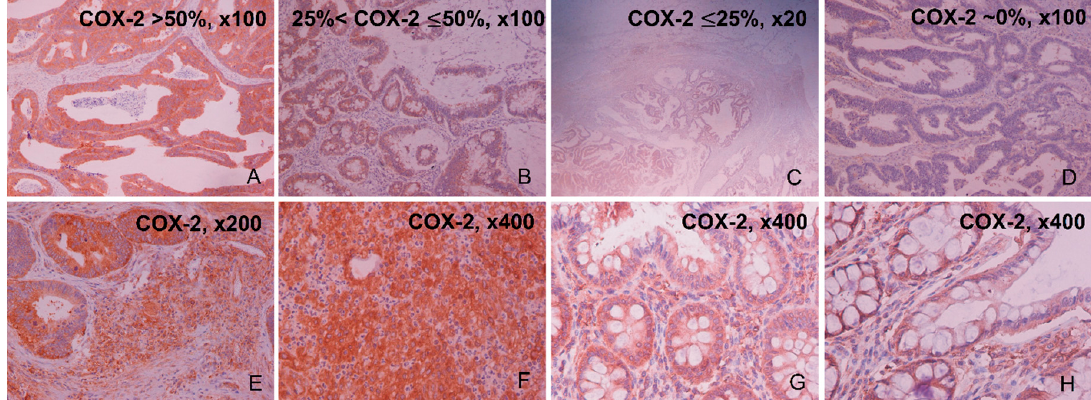
Figure 1. Representative slides of COX-2 staining in colorectal cancer (CRC) by immunohistochemistry (IHC). Colorectal adenocarcinomas with highly positive COX-2 immunoreaction (>50% of epithelial cancer cells; 22/49 (44.8%) CRC samples) ( A ), moderately positive (>25% and <50% of epithelial cancer cells; 14/49 (28.6%) CRC samples) ( B ), mildly positive (<25% of epithelial cancer cells; 5/49 (10.2%) CRC samples) ( C ), and negative COX-2 immunoreaction (9/49 (18.4%) CRC samples) ( D ). CRC slides were also imaged at the tumor’s stroma, containing mast cells, fibroblasts, pericytes, and endothelial cells. COX-2 positive stroma staining at ×200 ( E ) and ×400 ( F ). Adjacent to the tumor, normal slides were also imaged at the stroma region, with representative slides of COX-2 positive stroma staining at ×400 ( G , H ).